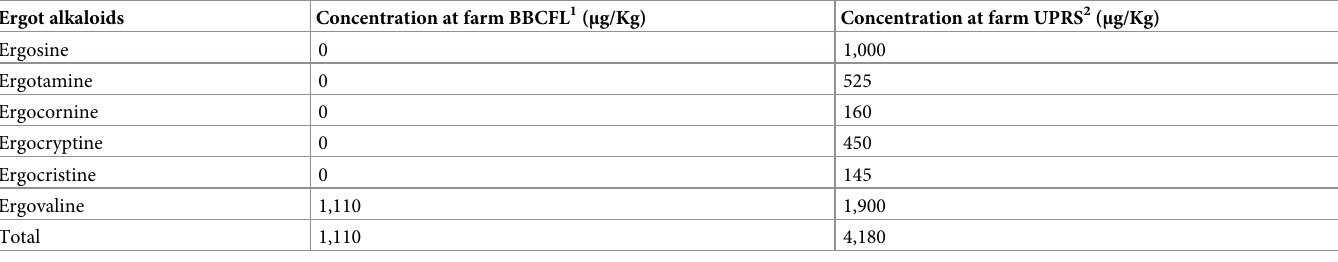
Table 1. Ergot alkaloid concentration of tall fescue pastures. Ergot